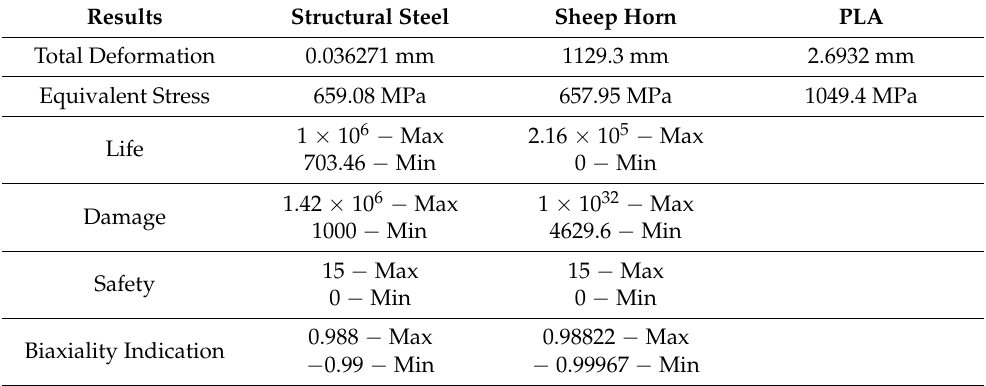
Table 5. Simulation study comparison for Rudraksha structure.